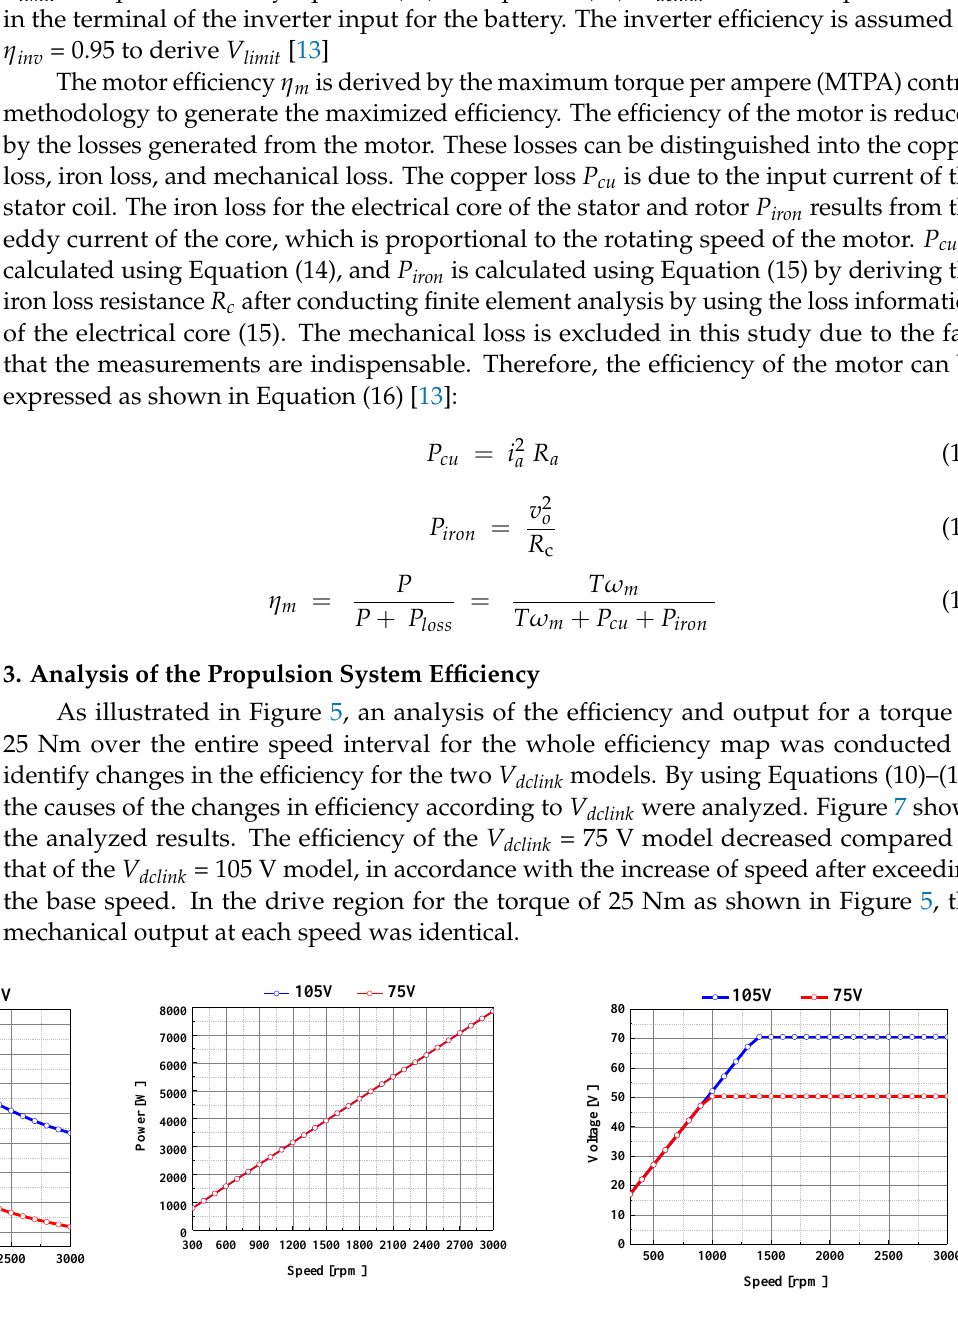
( c ) Figure 8. Current and loss according to V dclink : ( a ) current, ( b ) copper loss, and ( c ) iron loss.